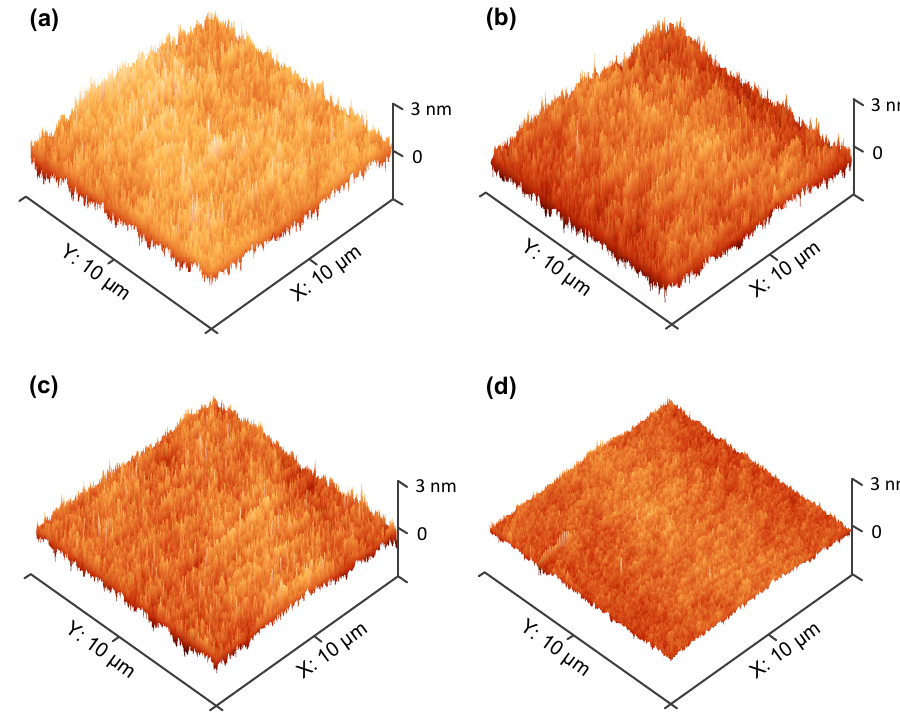
Figure 5. Three-dimensional AFM images of the deposited gate stacks with different ALD cycles of La 2 O 3 passivation layer on Ge substrates. ( a ) The control sample; ( b ) 5 ALD cycles of La 2 O 3 passivation layer; ( c ) 10 ALD cycles of La 2 O 3 passivation layer; and ( d ) 15 ALD cycles of La 2 O 3 passivation layer.